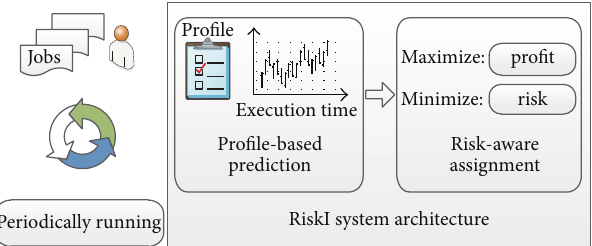
Figure 5: RiskI has two main parts, a profile-based execution algorithm for task execution time prediction and a risk-aware backup task assignment algorithm used to make scheduling based on range of time.